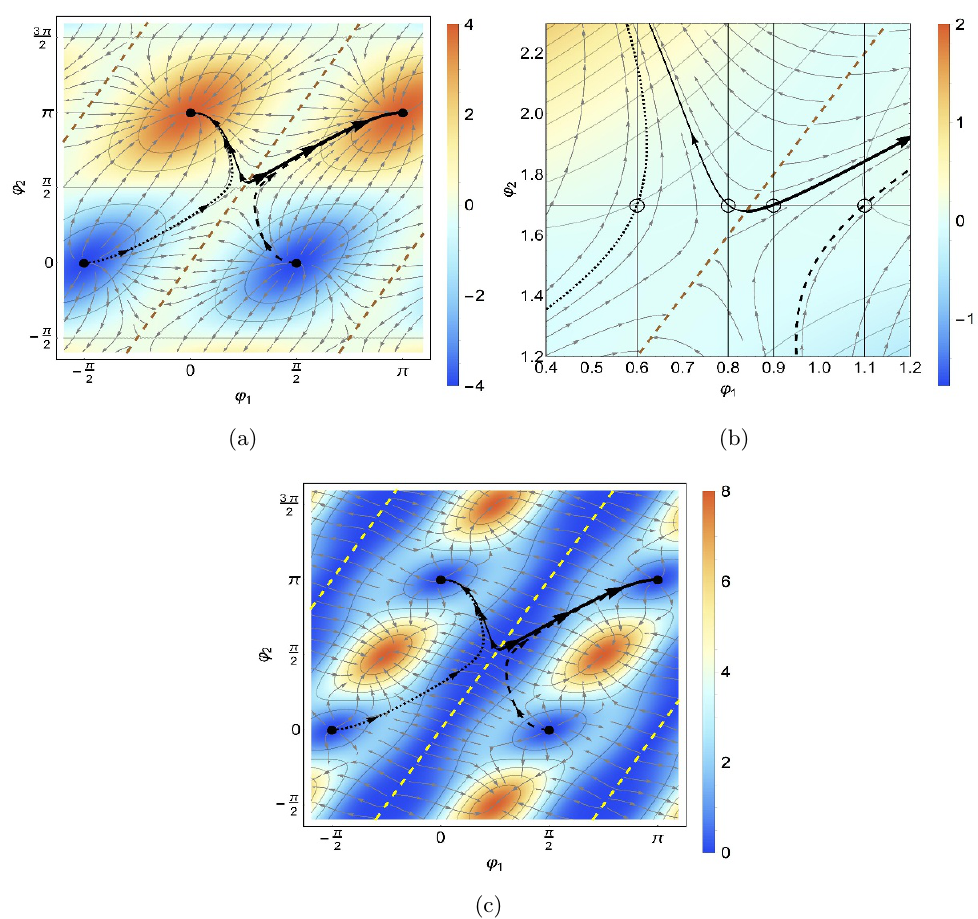
Figure 16 . SO(5) (cid:12)elds | case III; (a), (b) pre-potential and ~ r (cid:17) U (cid:0) (cid:13)ow, (c) potential and its gradient (cid:13)ow. The curves correspond to ’ 2 (0) = 1 : 7 and ’ 1 (0) = 0 : 8 -solid thin curve, ’ 1 (0) = 0 : 6 | dotted curve, ’ 1 (0) = 1 : 1 | dashed curve, ’ 1 (0) = 0 : 9 | solid thick curve. The initial points for the numerical simulations are shown at (cid:12)gure (b) which is a blow-up of the central region of (cid:12)gure